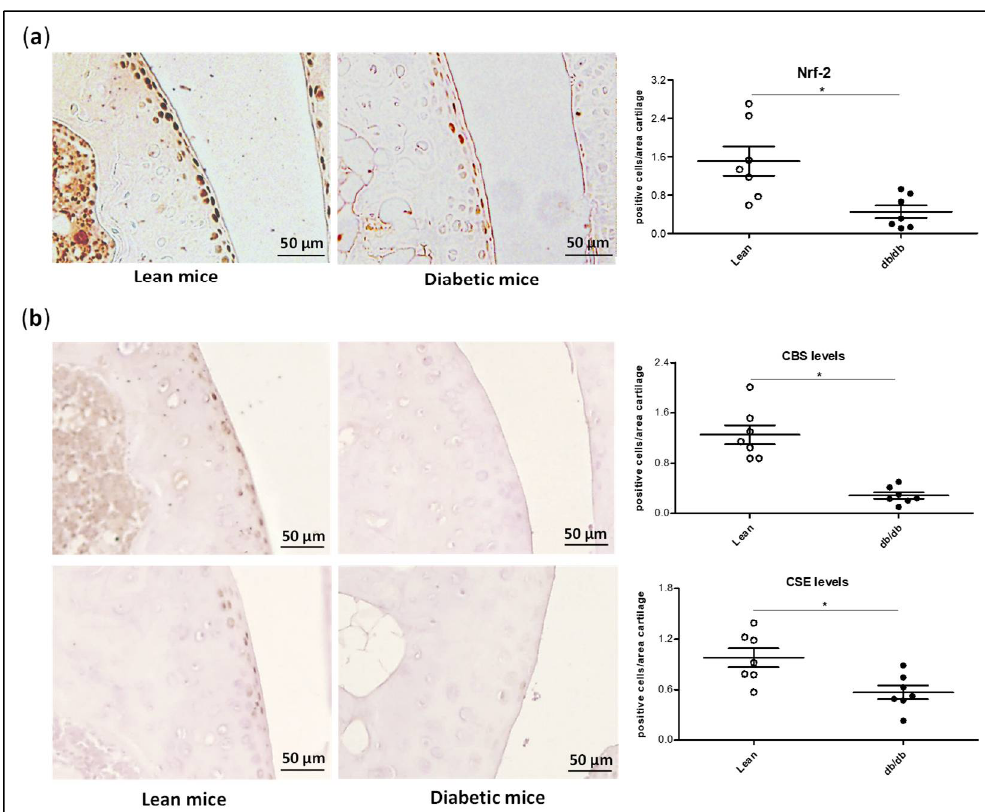
Figure 7. Expression of Nrf-2 and H 2 S synthesising enzymes is diminished in the cartilage from diabetic mice. Histological slides of joints from lean or diabetic (db/db) mice were employed to analyse cartilage expression of ( a ) Nrf-2 and ( b ) H 2 S synthesising enzymes CBS and CSE by immunohistochemistry. Images on the left show representative micrographs from one experiment (n = 7). Values are mean ± SEM. * p ≤ 0.05 CBS, cystathionine β -synthase; CSE, cystathionine γ -lyase; Nrf-2, nuclear factor erythroid 2-related factor 2.